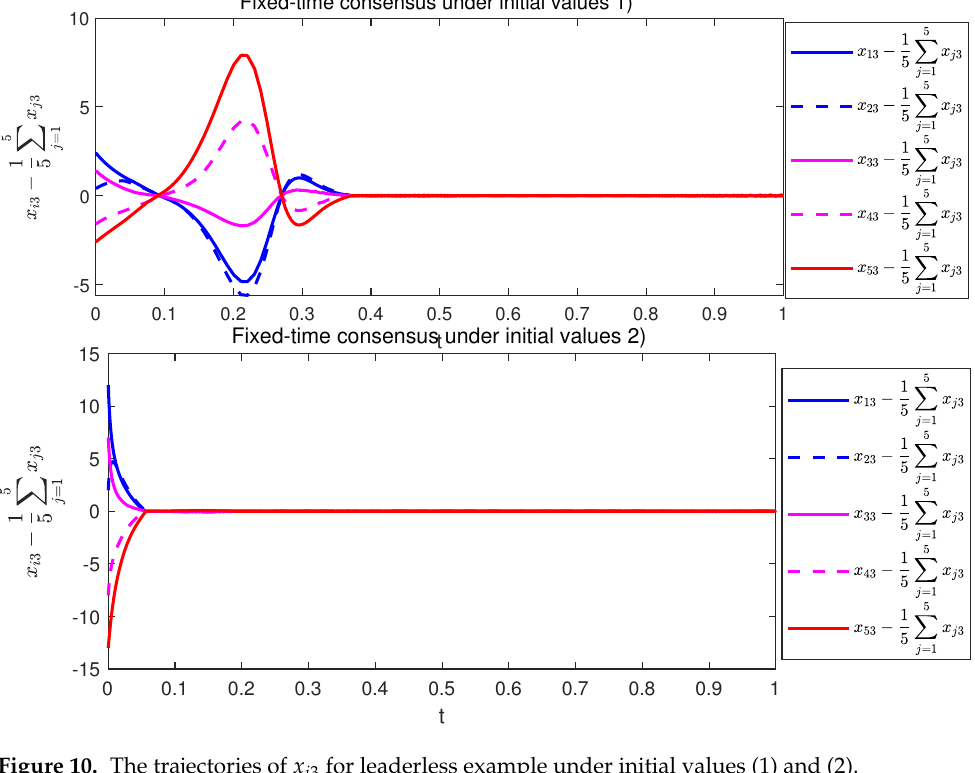
Figure 10. The trajectories of x i 3 for leaderless example under initial values (1) and (2).